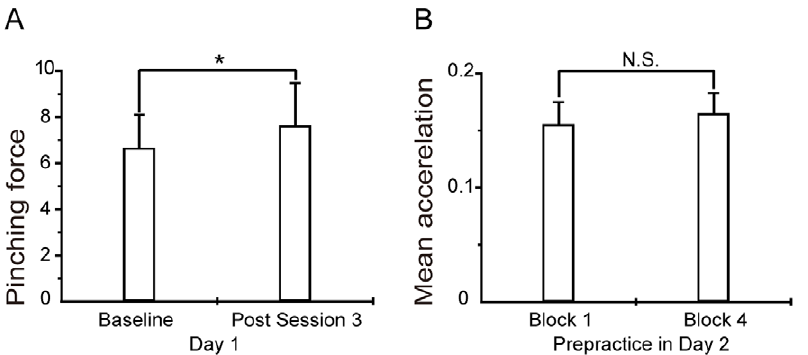
Figure 3. Mean pinching force changes in initial skill-training on Day 1 and mean acceleration changes in prepractice on Day 2. (A) Changes of the mean pinching force in the initial skill training between baseline (before session 1) and post session 3. Y axis indicates mean pinching force (kg). Error bars show the SD. * P , 0.05. (B) Mean accelerations in the motor prepractice between block 1 and block 4. Y axis indicates mean accelerations (cm/s 2 ). Error bars show the SEM. N.S. not significant.